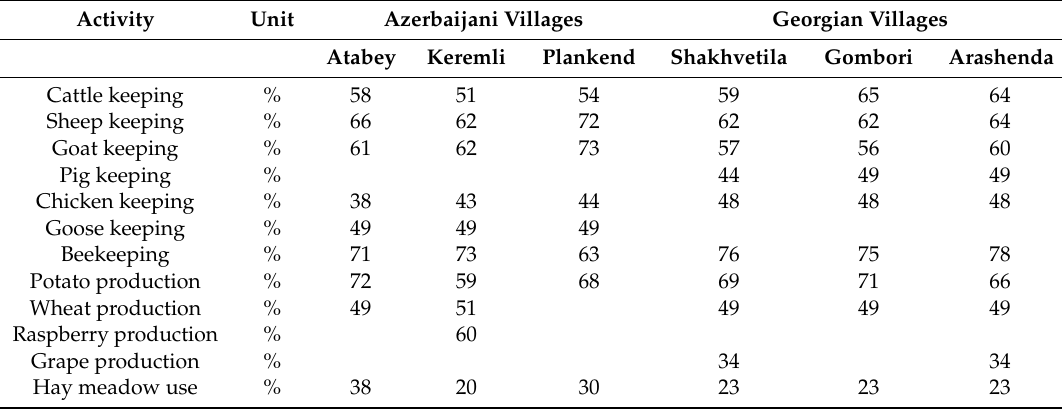
Table 4. Economic performance (Contribution Margin Ratios, CMRs) for agricultural activities. A higher CMR indicates a better economic